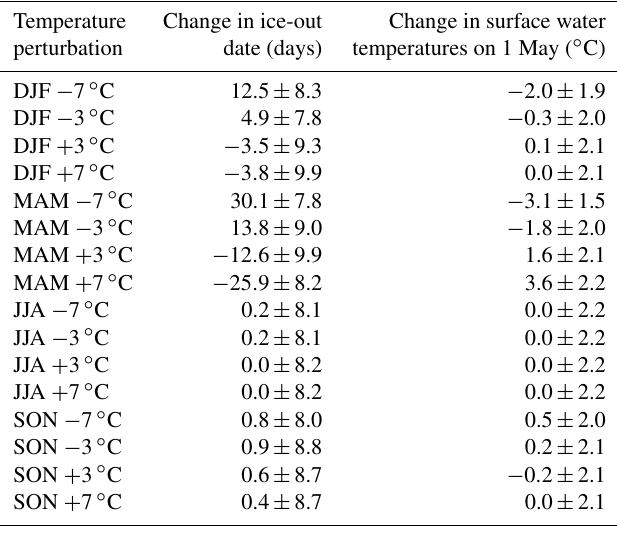
Table A4. Results from the lake energy balance model for air temperature perturbations showing the change in ice-out dates and lake water temperatures relative to the control simulation (average ice-out date: 23 April ± 6d; average lake water temperature: 4 . 1 ± 1 . 5 ◦